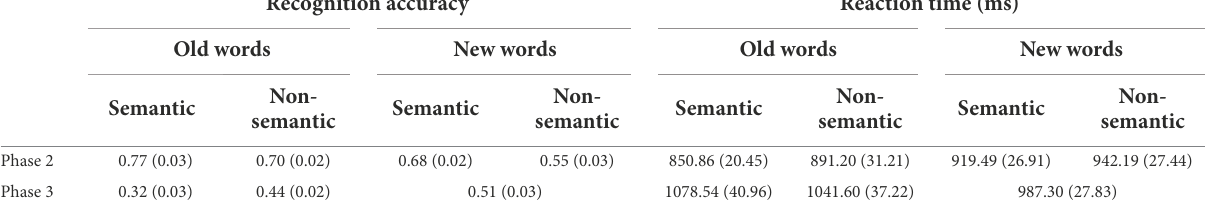
TABLE 1 Performance during Phase 2 and Phase 3 in the semantic and non-semantic conditions.